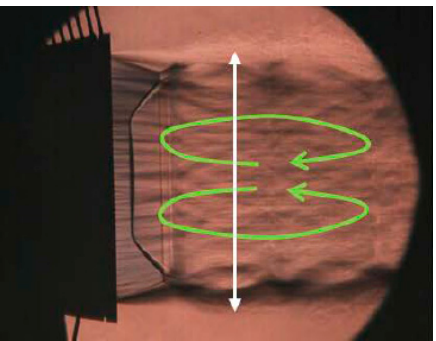
Figure 26. Flow features at a TOP contoured nozzle exit, viewed using Schlieren technique. Reprinted with permission from Ref. [43] (2017).